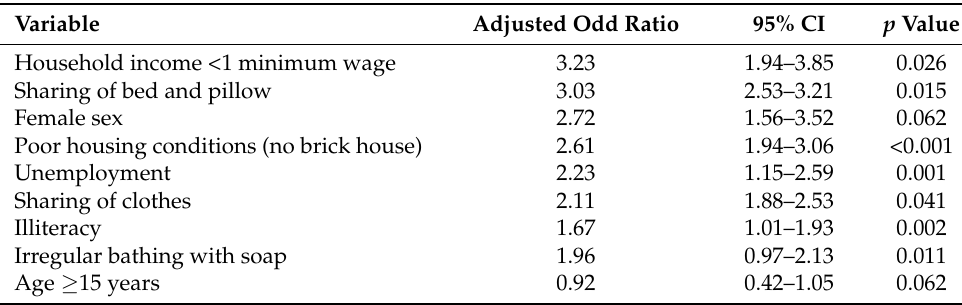
Table 4. Multivariate analysis of factors independently associated with